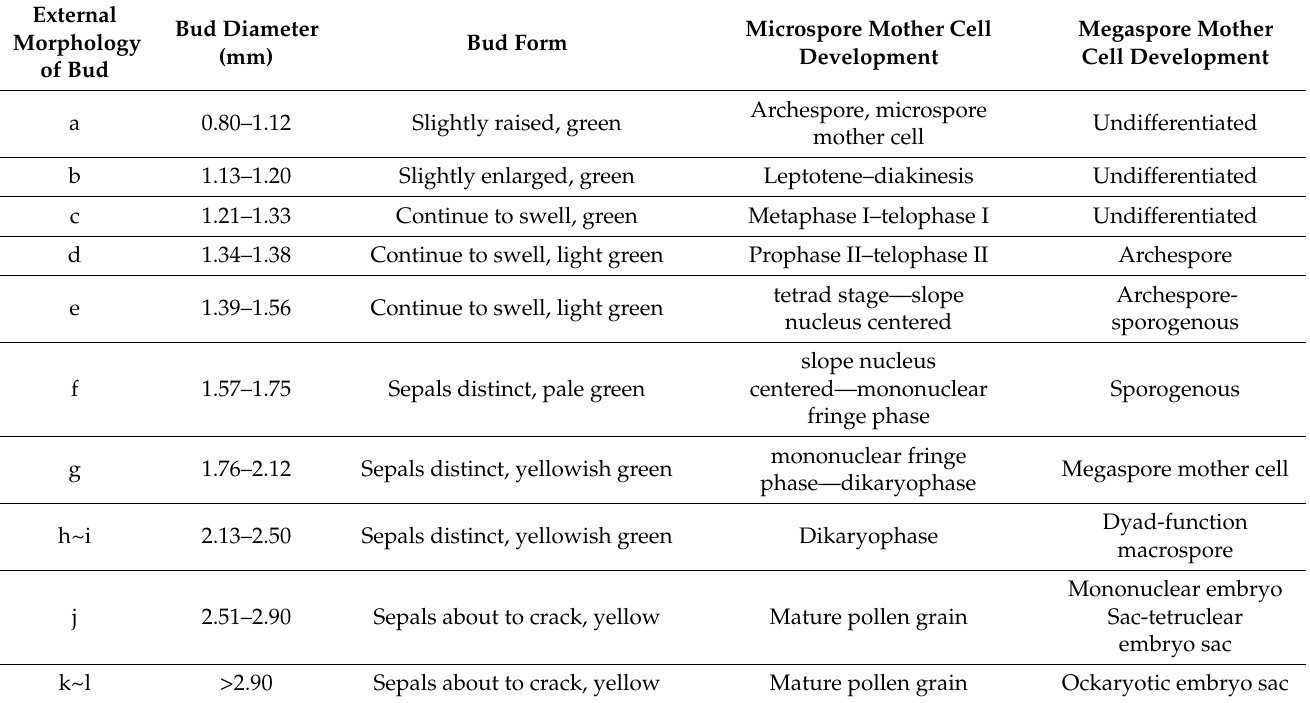
Table 3. The relationships between flower morphological characteristics and the male and female gametophytes develop- ment stages in ‘Maya’ Jujube.